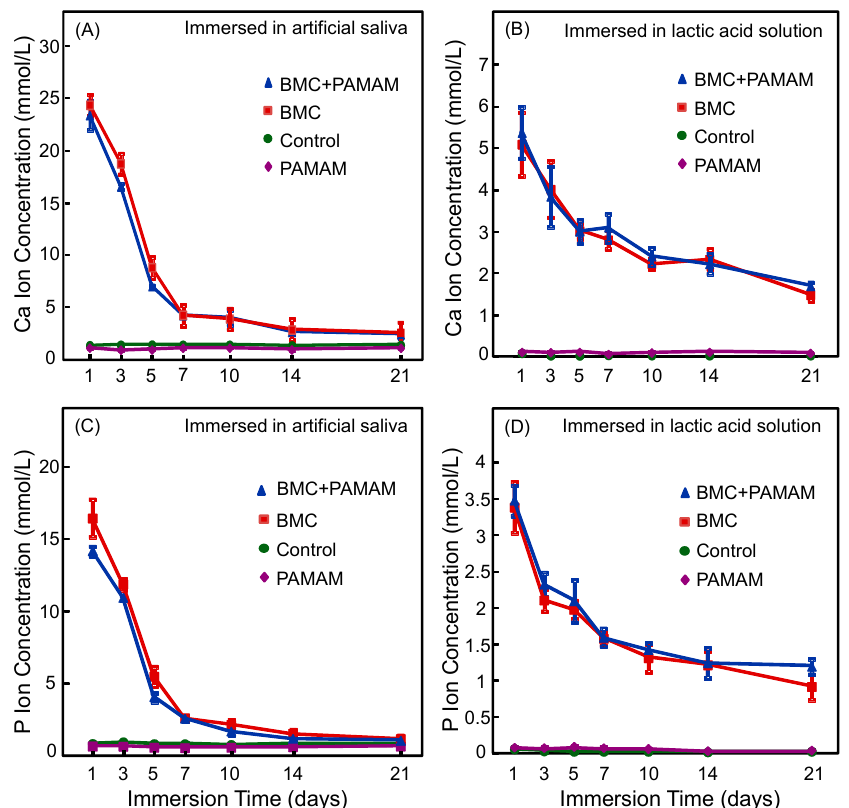
Figure 2. Ca and P ion concentrations (mean ± SD; n = 6). ( A , C ) Ca and P concentrations in artificial saliva, ( B , D ) Ca and P ion concentrations in lactic acid. The BMC group and BMC + poly (amido